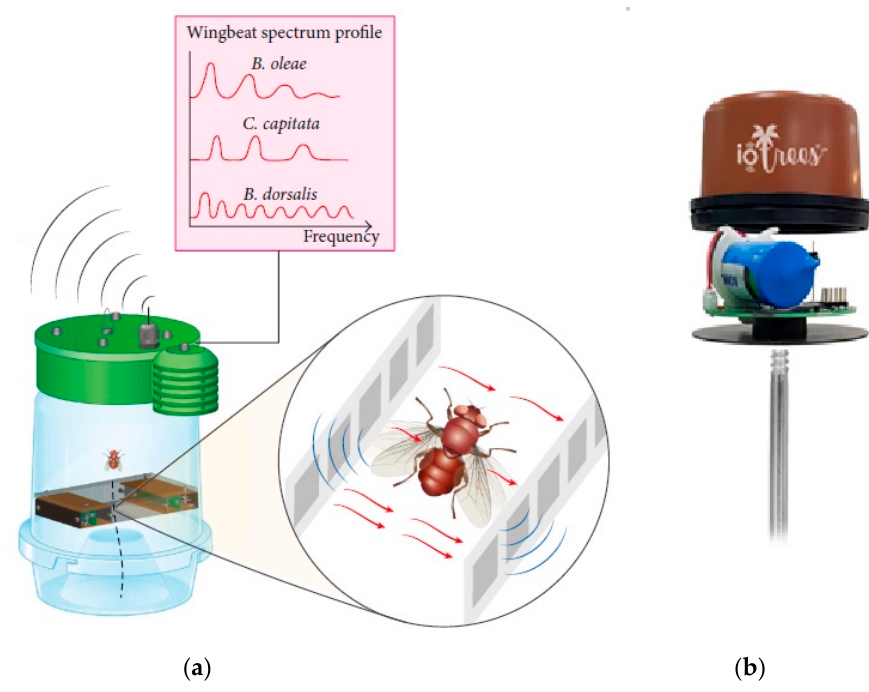
Figure 3. Echo-acoustic trap and sensor: scheme detailing the functioning of an automatic acoustic insect trap ( a ) [51]. Automatic detection device with seismic sensor for detection of weevils in palm trees (IOSTrees, Spain) ( b ).